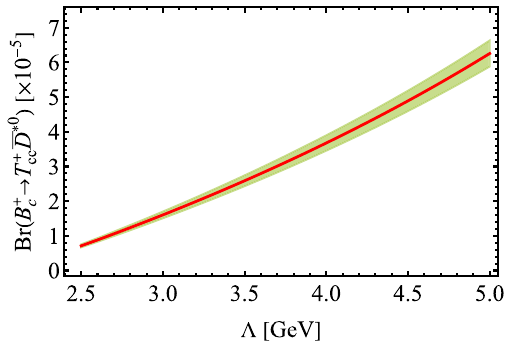
Fig. 5 Rescattering diagrams contributing to B + c → T +